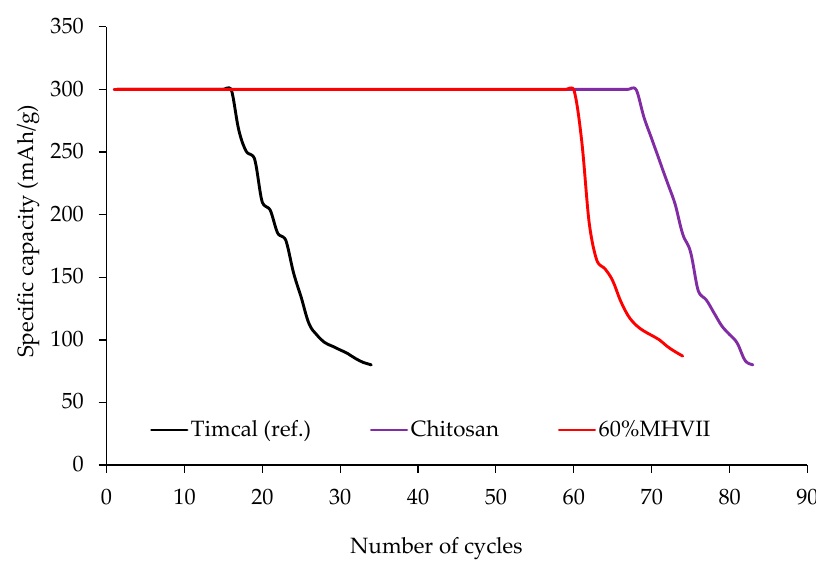
Figure 10. Cycling results for the Li-O 2 batteries with the prepared carbons .